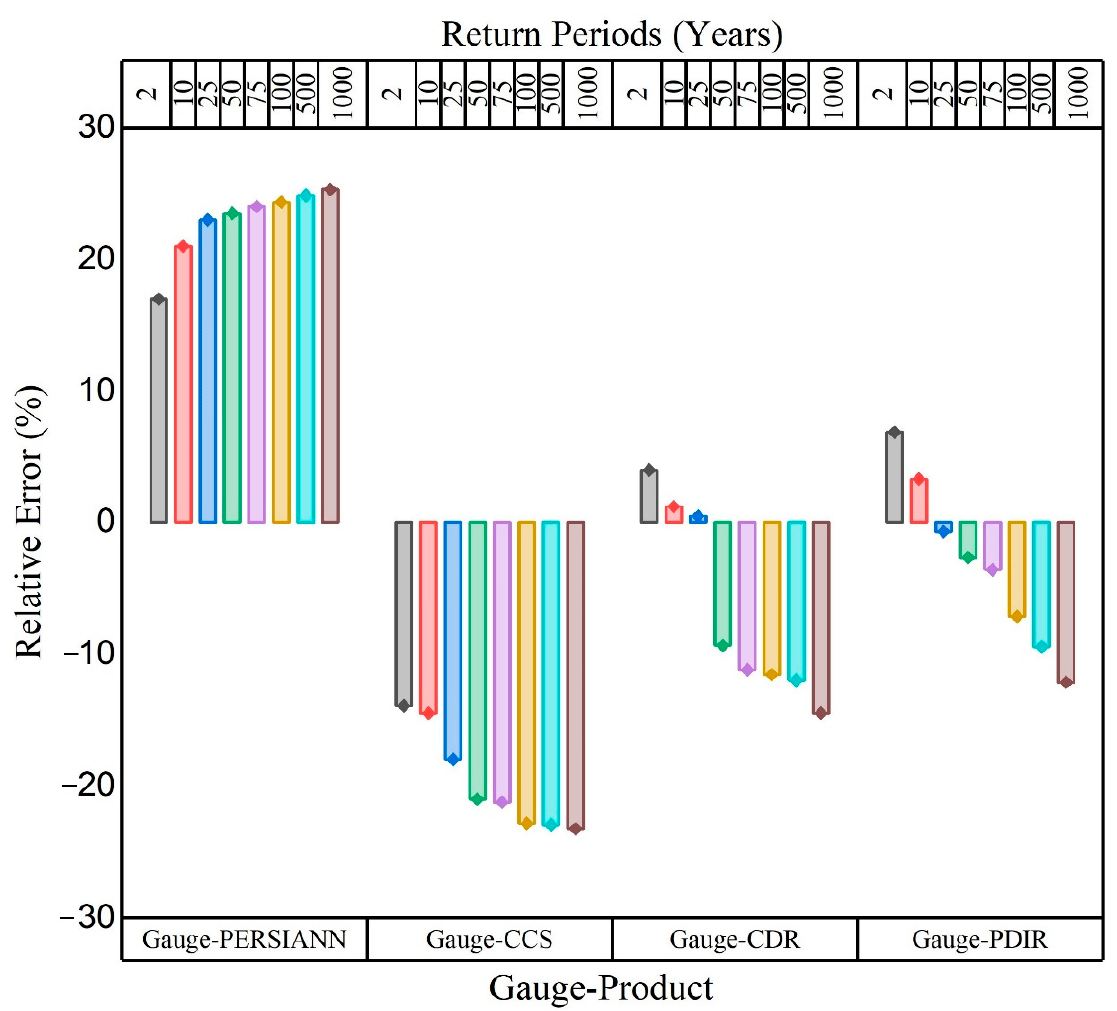
Figure 11. Percent relative difference plots for intensity duration frequency (IDF) curves between gauge and PERSIANN family products. Return periods of 2, 10, 25, 50, 75, 100, 500, and 1000 years were used as indicated on the top axis for each combination.